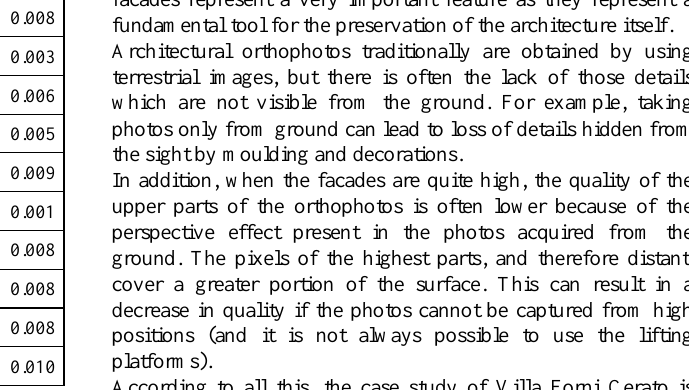
Table 7. Evaluation of the error on the markers